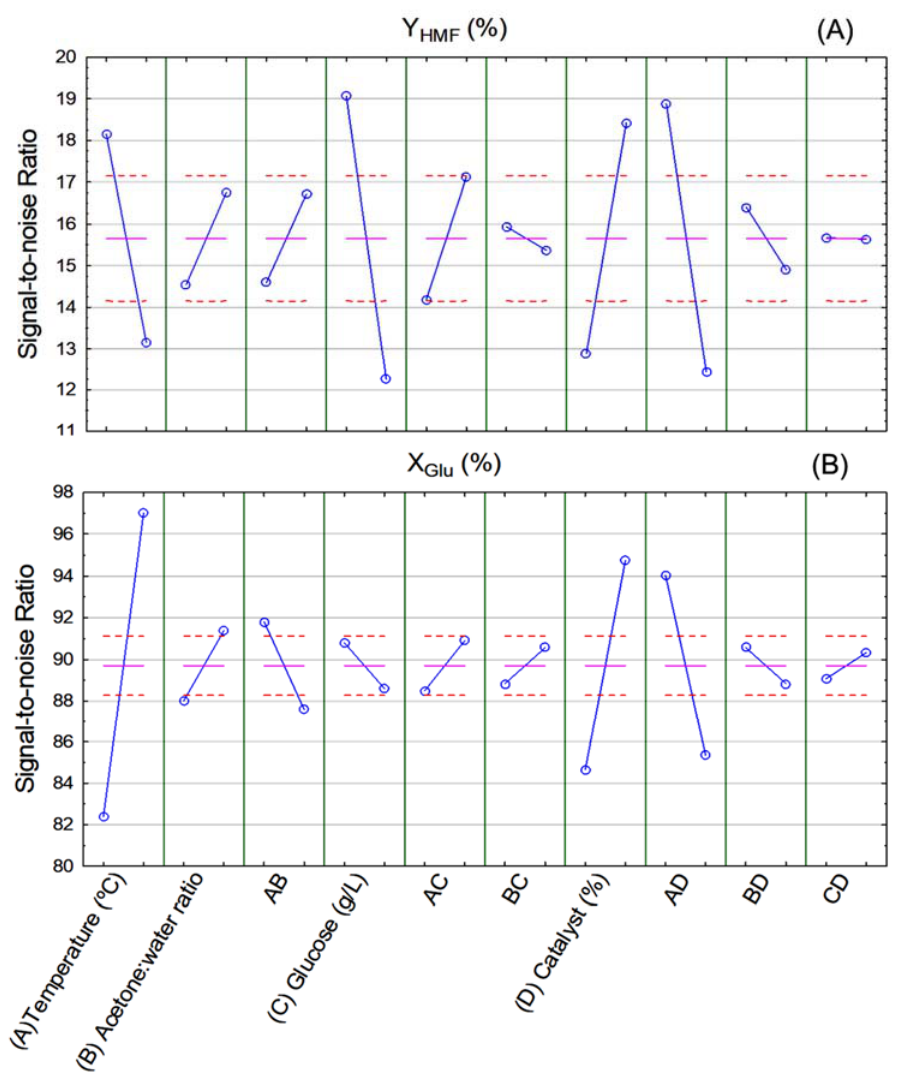
Figure 5. Signal ‐ to ‐ noise ratio (SN ratio) of ( A ) HMF yield (Y HMF %) and ( B ) glucose conversion (X Glu %) response variables.